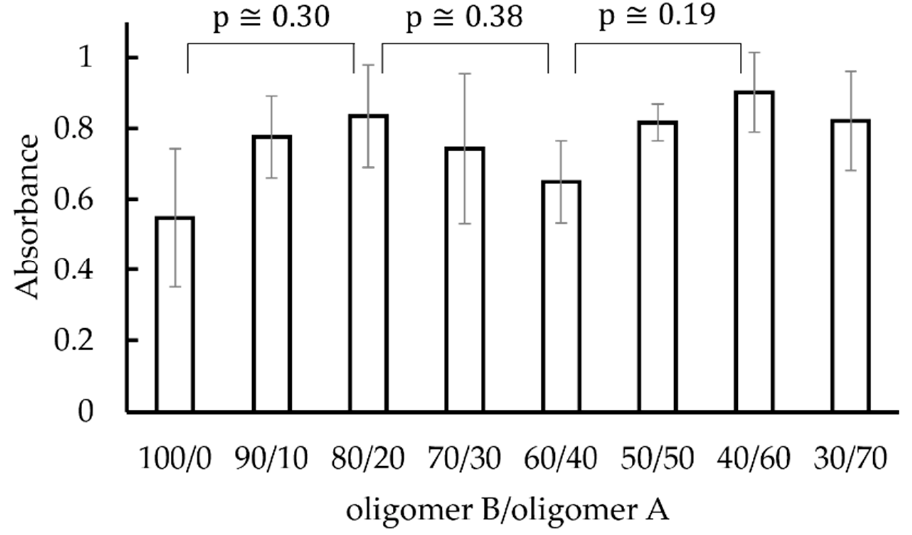
Figure 4. Absorbance of pure water where the stained biofilm, which is formed on polysiloxane films with various compositions of oligomer B/oligomer A ranging from 100/0 to 30/70, was dissolved. The standard error is shown as an error bar.